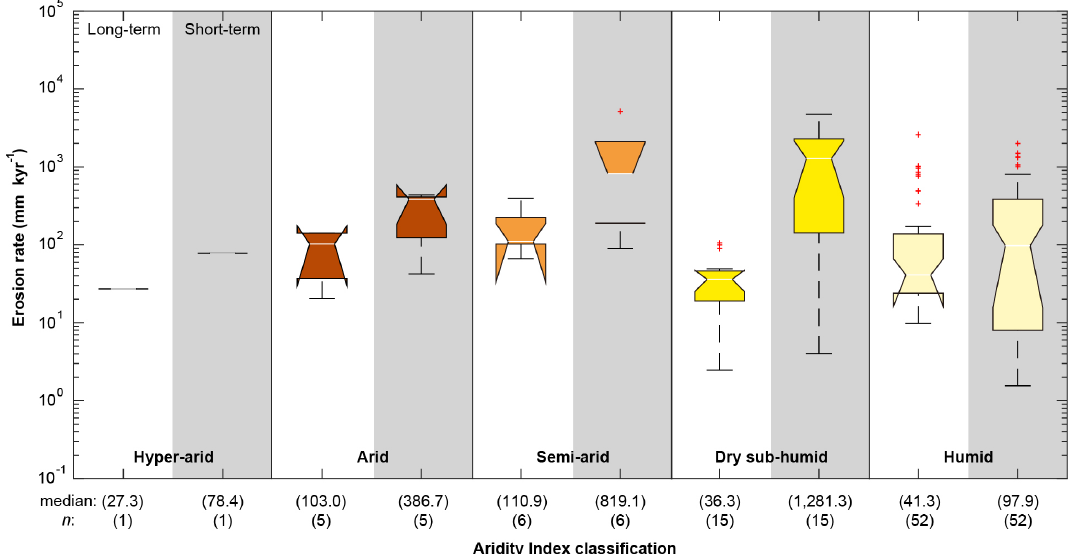
Figure 3. Long- and short-term erosion rates at co-located points as classified by the Aridity Index. Note that n = 79 is substantially smaller than the whole dataset (Fig. 2). However, the patterns evident in Fig. 2 are upheld in this limited co-located